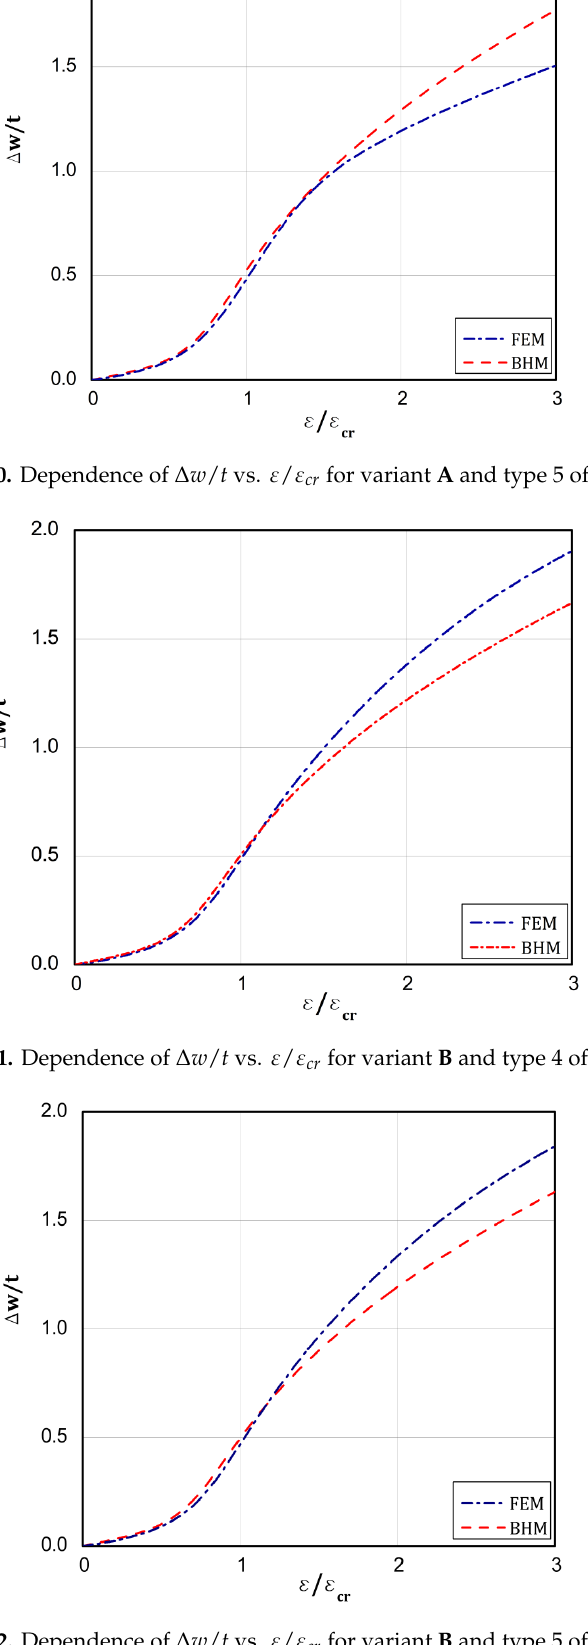
Figure 12. Dependence of ∆ w / t vs. ε / ε cr for variant B and type 5 of